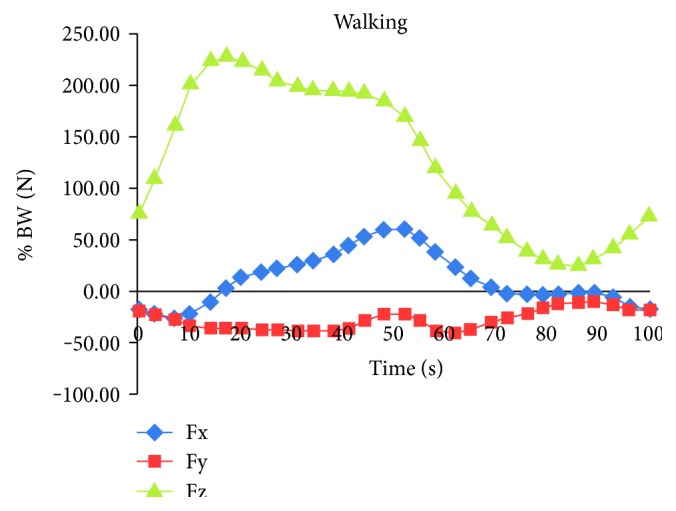
The force components of the hip contact force for walking [17].